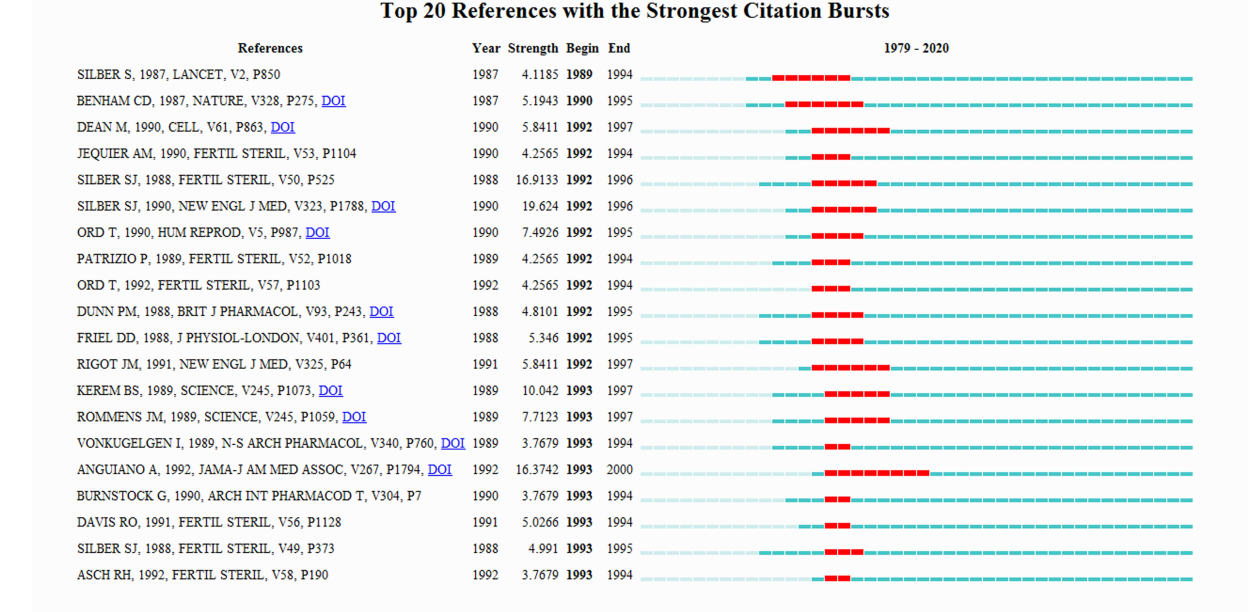
Fig. 9. The top 20 references with the strongest citation bursts in the co-citation